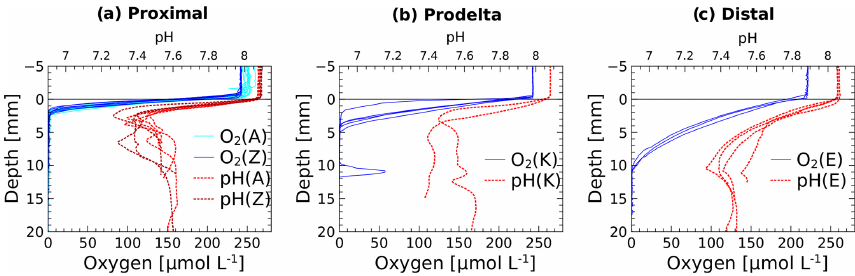
Figure 2. Dissolved oxygen and pH micro-profiles recorded in situ at the sediment–water interface at stations A, Z, K and E. Stations A and Z are located in the proximal zone, K in the prodelta, and E in the distal zone (i.e., continental shelf).